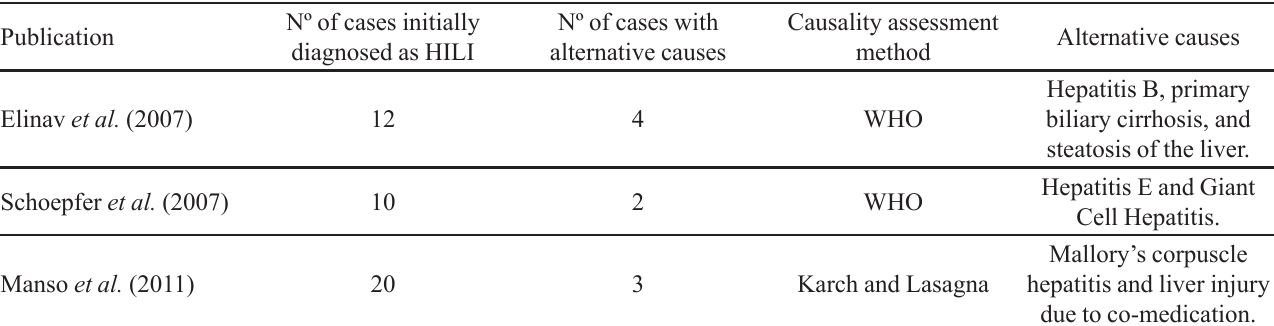
TABLE I - Frequency of alternative causes proposed for cases initially diagnosed as HILI